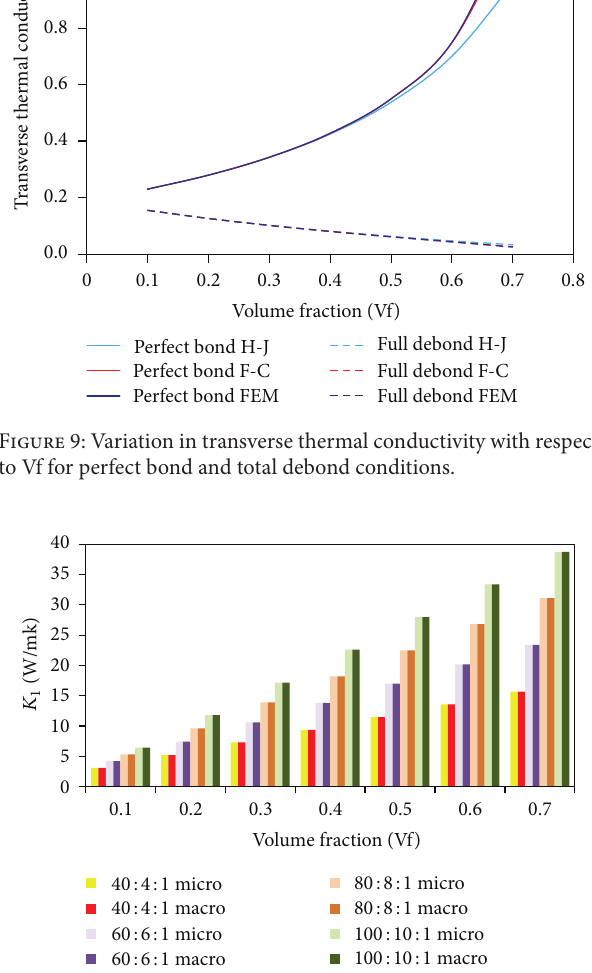
Figure 10: Variation in 𝐾 1 of hybrid composite with respect to Vf for different 𝐾 𝑓1 : 𝐾 𝑓2 : 𝐾 𝑚 .